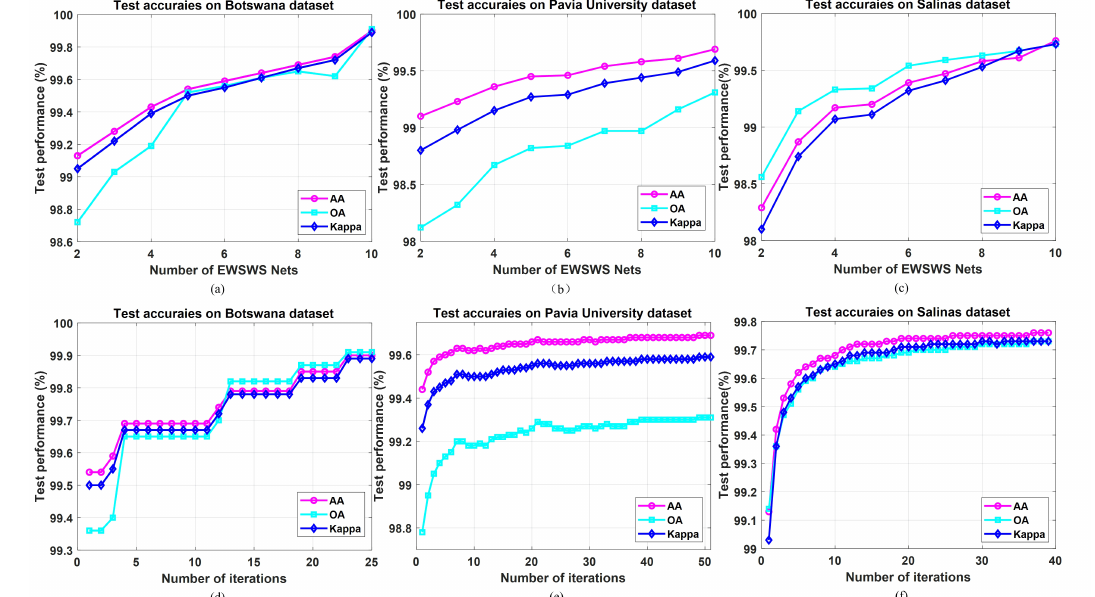
Figure 11. Classification results of the DWDNN with different numbers of EWSWS networks and different iterations (10 EWSWS networks). ( a – c ) Classification results of the DWDNN with different numbers of EWSWS networks. ( d – f ) Classification results of the DWDNN with different iterations (10 EWSWS